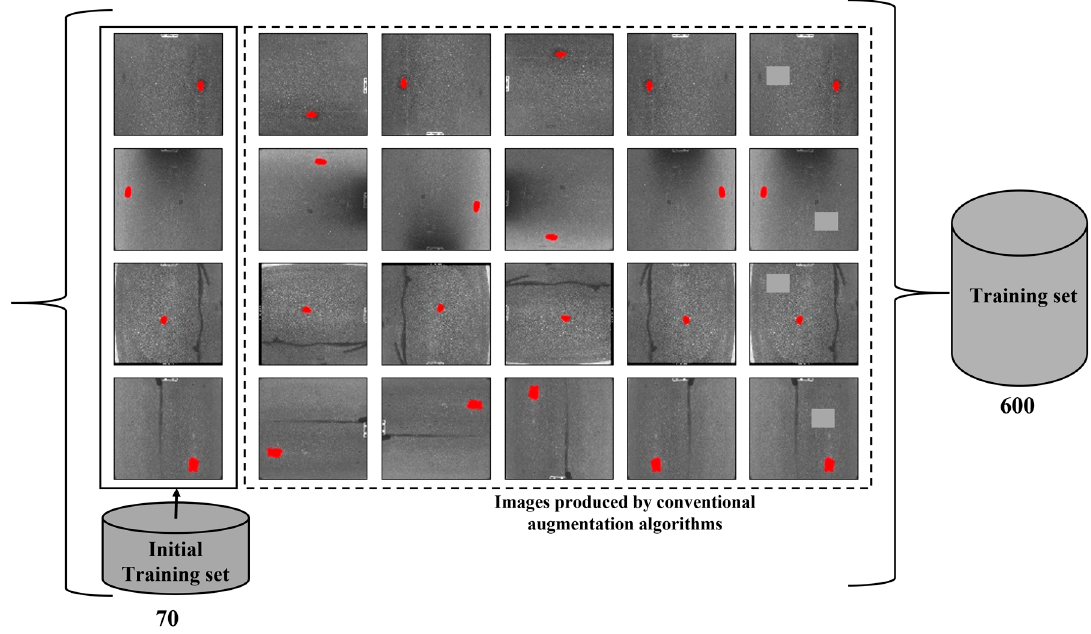
Figure 4. Training set after augmentation by the conventional algorithm. The red marks illustrate the labeled pit area. labeled pit